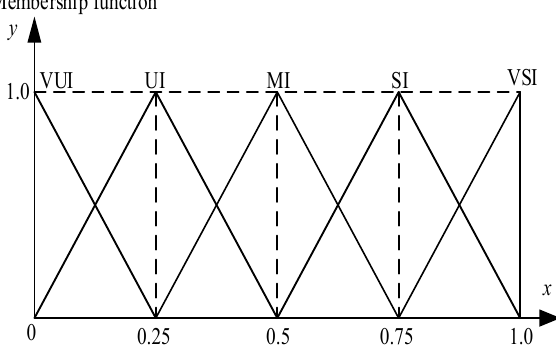
Figure 4. Membership functions for rating risk factor weights.